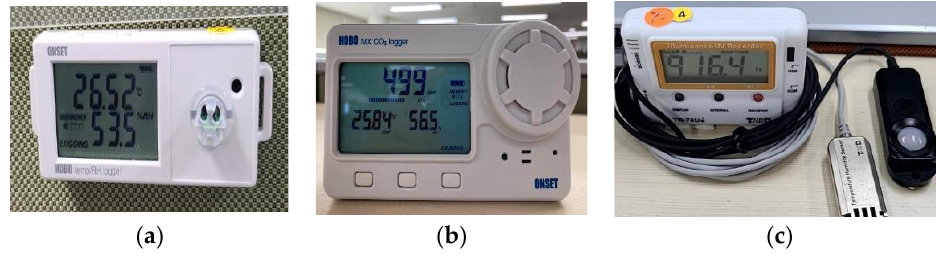
Figure 3. Sensors used in the study (( a ) = UX100-011A, ( b ) = MX1102A, ( c ) = TR-74Ui-S).